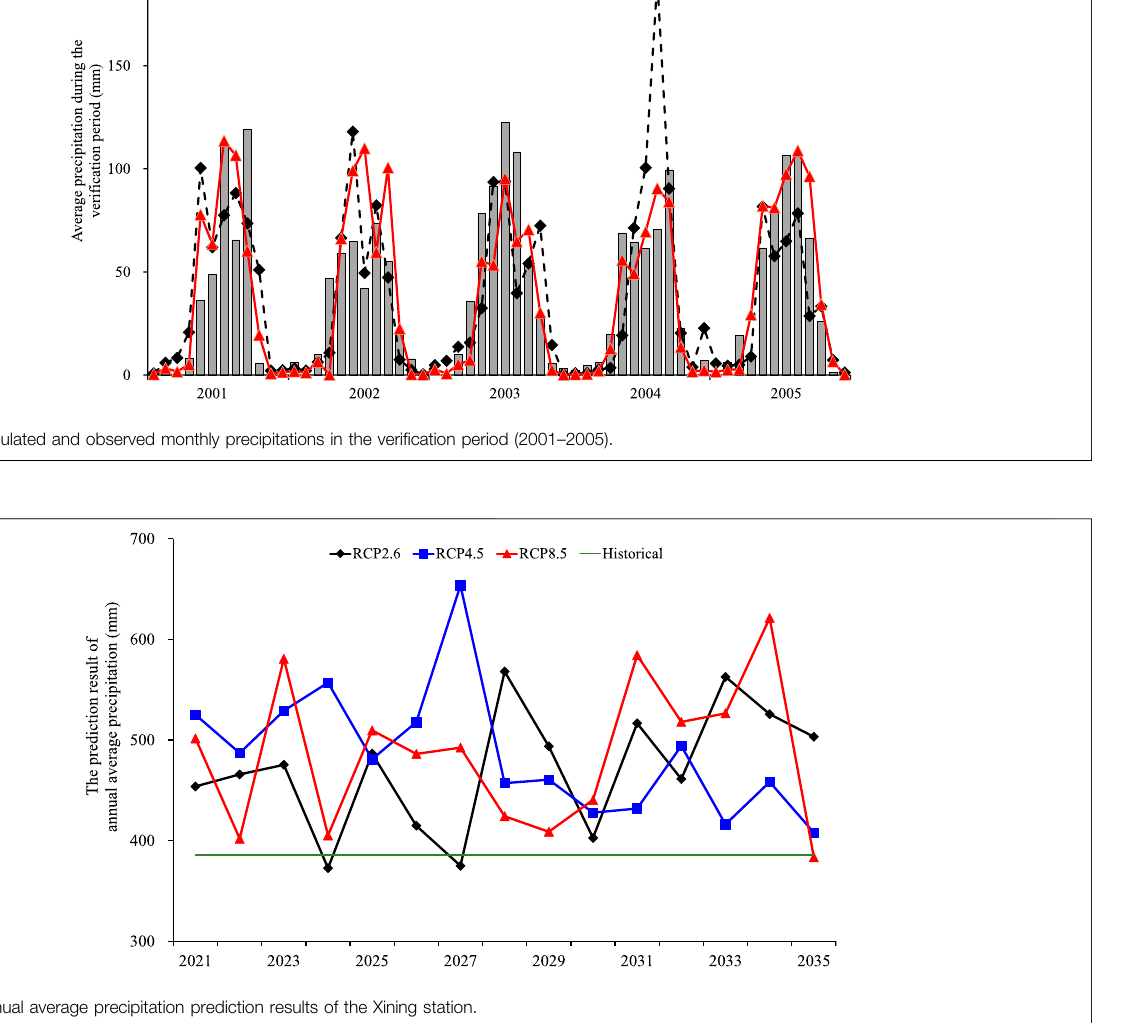
Frontiers in Earth Science |